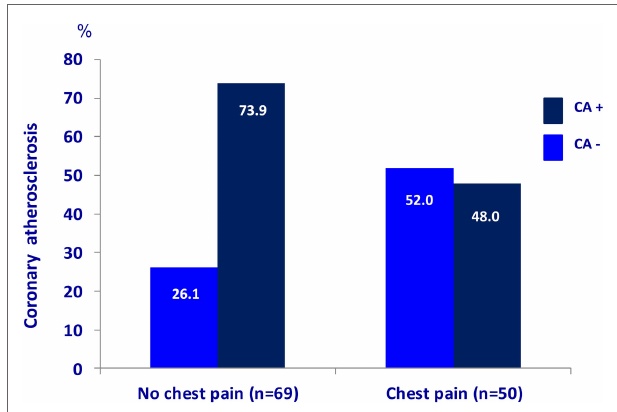
FigUre 2 | chest pain and coronary atherosclerosis in ra and as . Presence of coronary atherosclerosis (examined with multidetector computed tomography) in rheumatoid arthritis and ankylosing spondylitis patients ( n = 119) with and without chest pain. RA, rheumatoid arthritis; AS, ankylosing spondylitis.